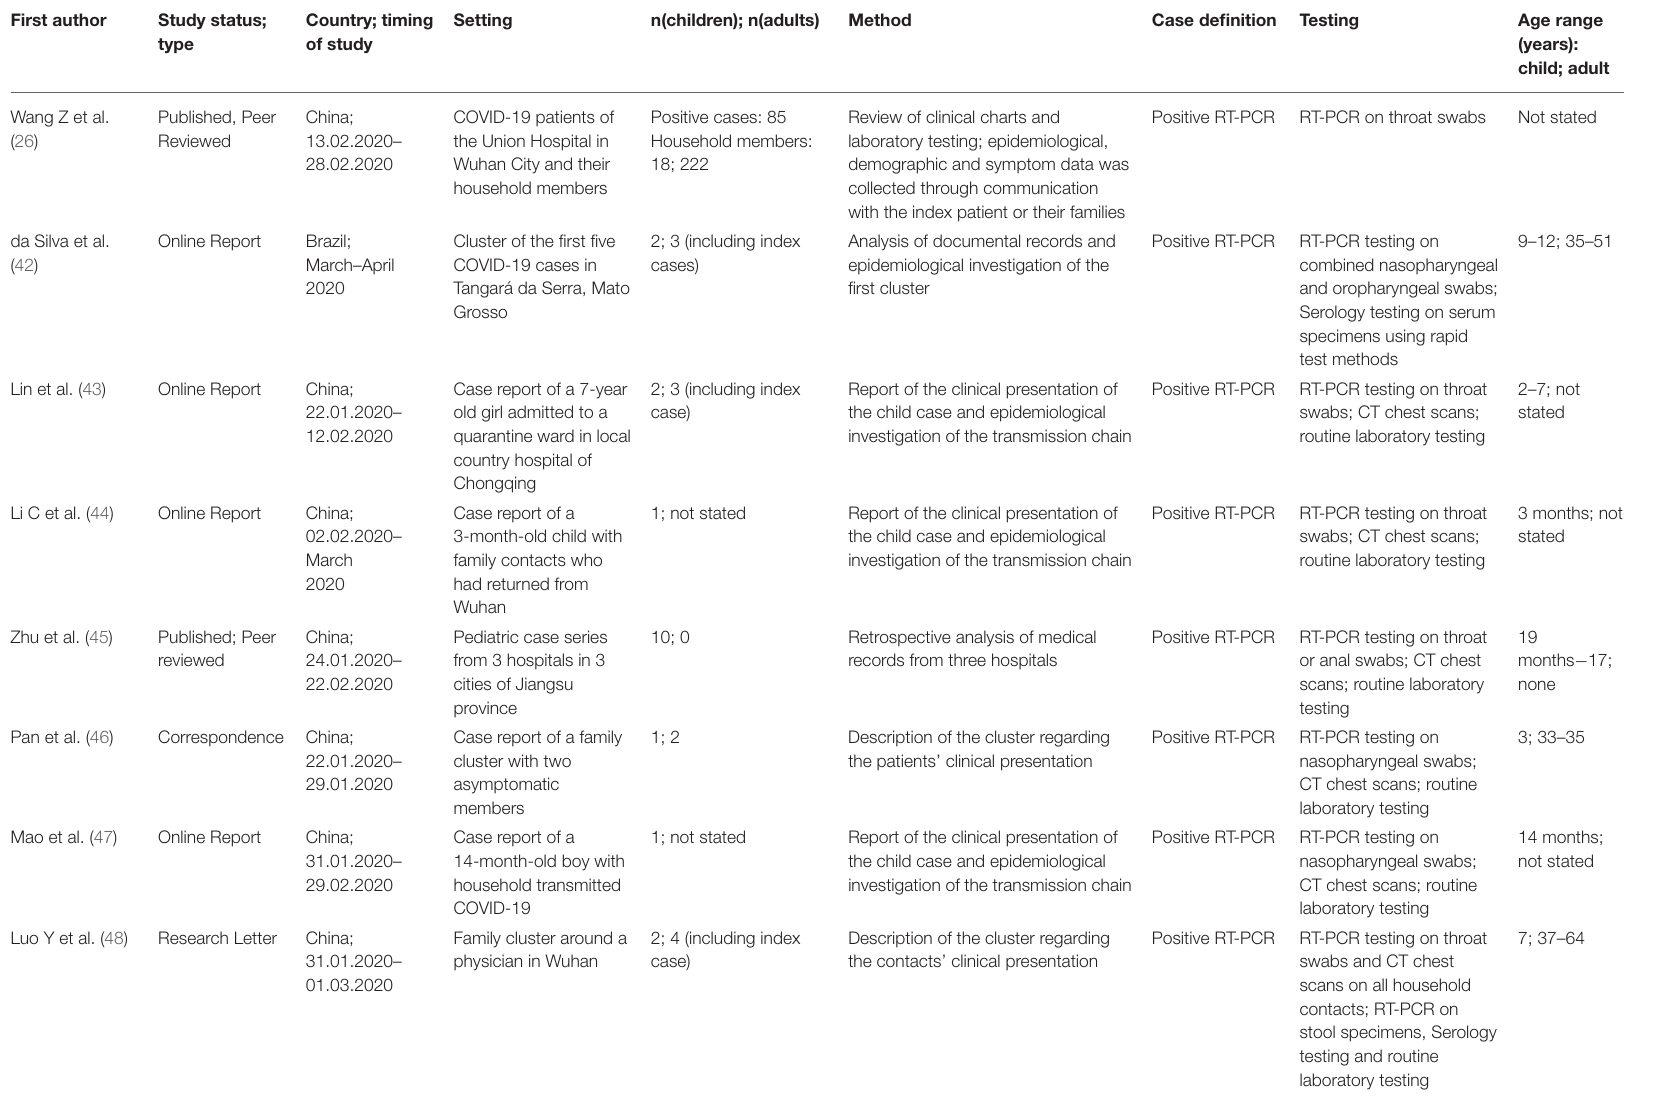
TABLE 2 | Characteristics of studies included in qualitative synthesis, excluded from quantitative review for insufficient data accuracy or small sample